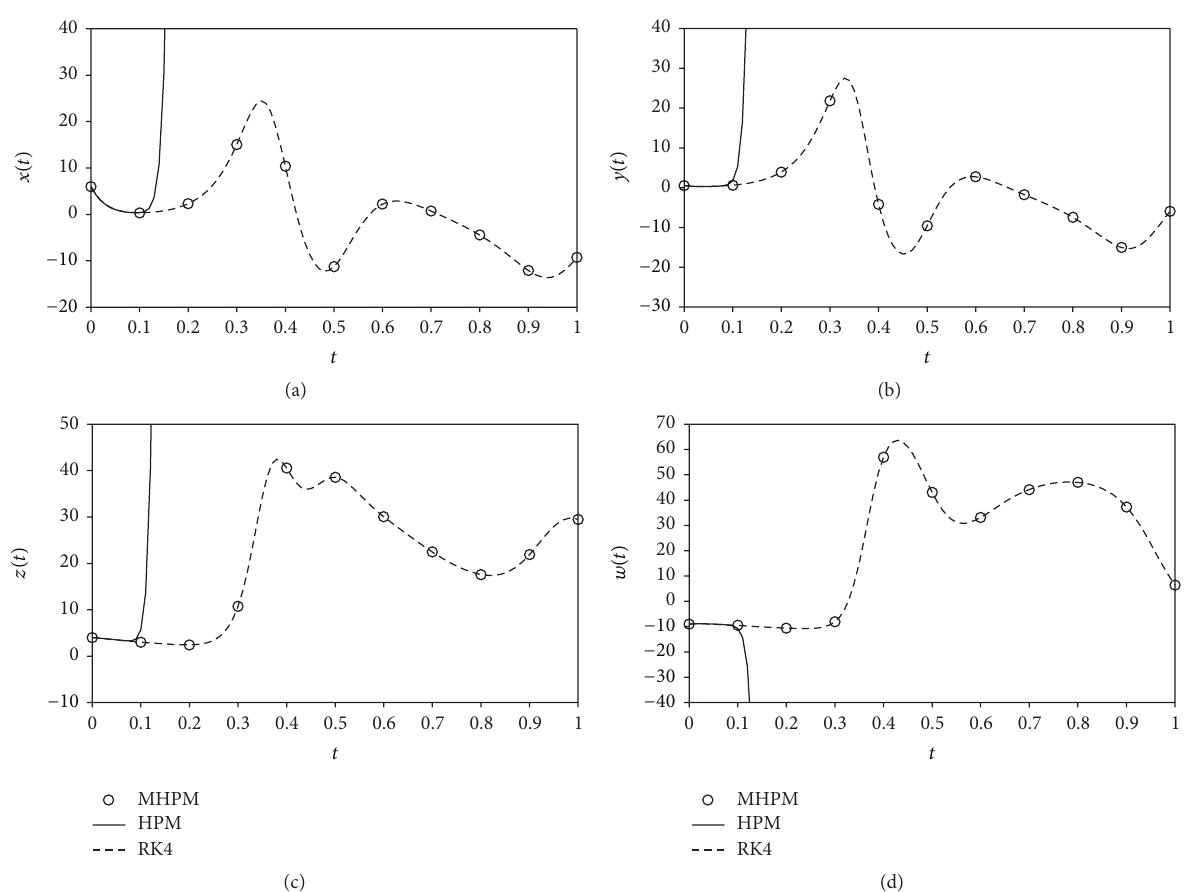
Figure 7: Comparison among 15-term HPM (solid line), MHPM (circle), and RK4 (dash line) for Case (3) of hyperchaotic L¨u system. 𝑦 = 2.0 + 46.00𝑡 + 126.0000000𝑡